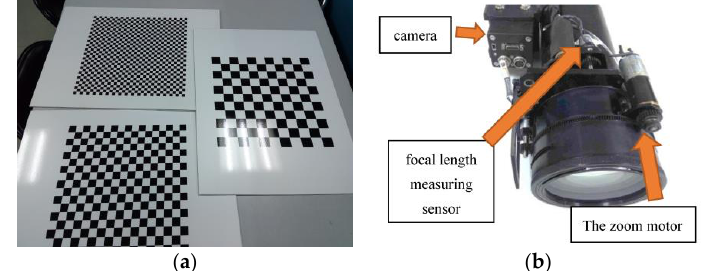
Figure 10. ( a ) A plane containing a chessboard pattern; ( b ) The zoom lens camera (not yet mount in the electro-optical stabilized imaging system).